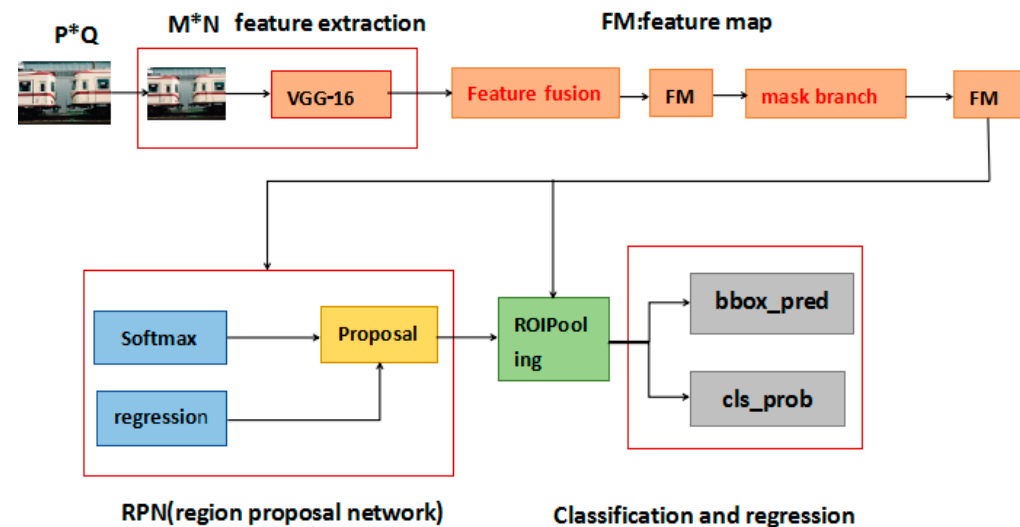
Figure 1. The architecture of AF R-CNN. The red part is the module we added above the original structure. The AF R-CNN is composed of four modules: A deep convolutional network, VGG-16, that extracts features, feature fusion, and the attention modules, and a Faster R-CNN detector that uses the region proposal network (RPN).